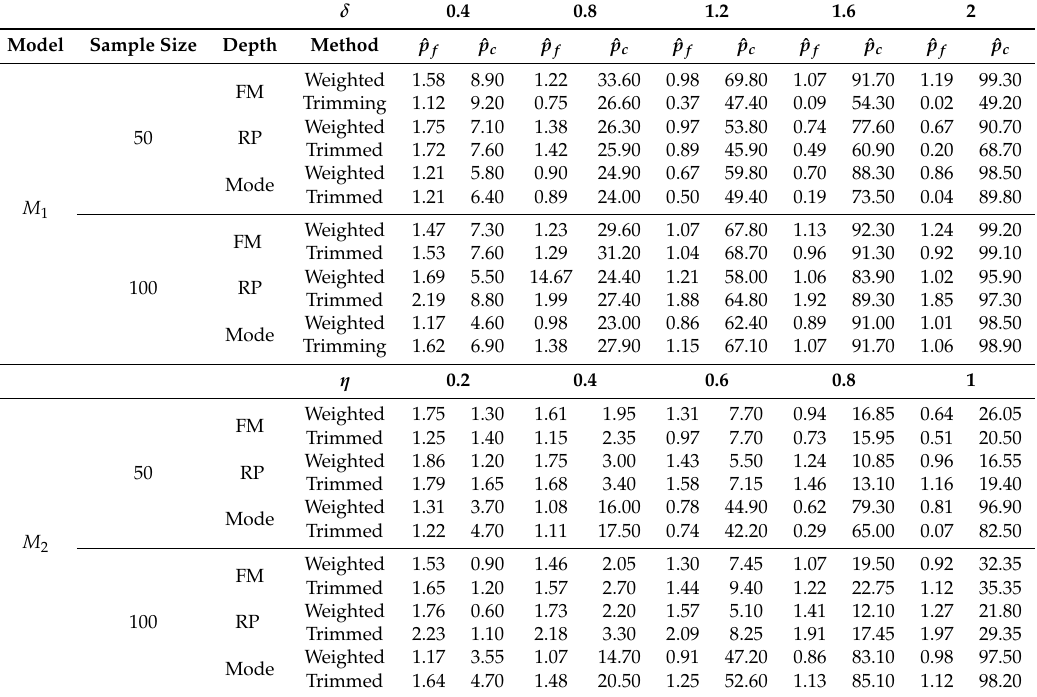
Table 4. Empirical values of ˆ p f and ˆ p c , with ρ = 0.3 (assuming dependence between curves).